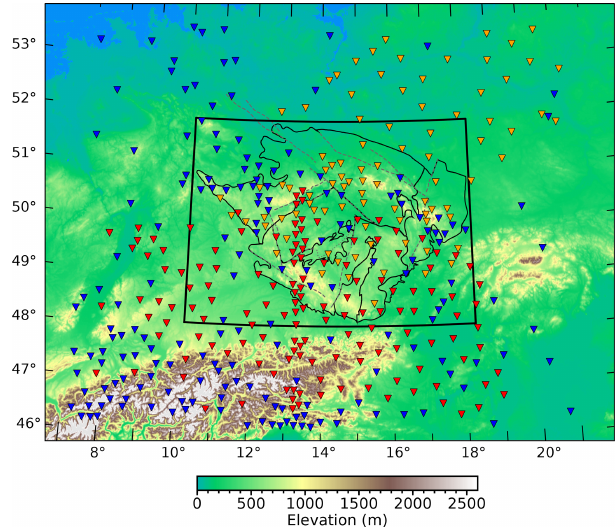
Figure 2. Map of the AlpArray seismic stations (red), temporary stations from previous passive experiments (orange), and permanent (blue) stations available in the European Integrated Data Archive (http://www.orfeus-eu.org/eida, last access: 1 May 2021). The mod- elled region is framed, and the contours of geological units from Fig. 1 are